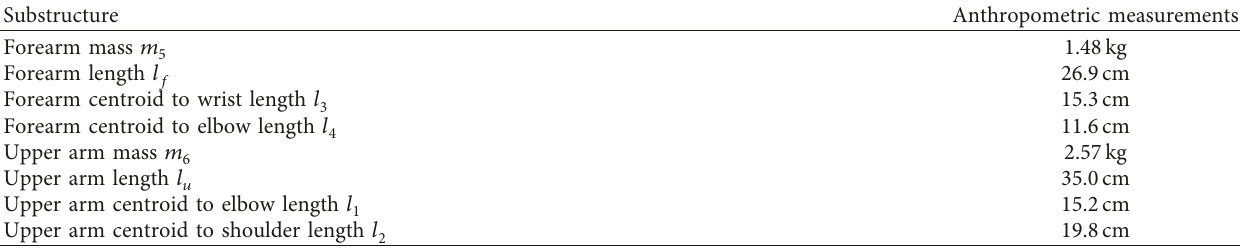
Table 2: Standard anthropometric parameters.